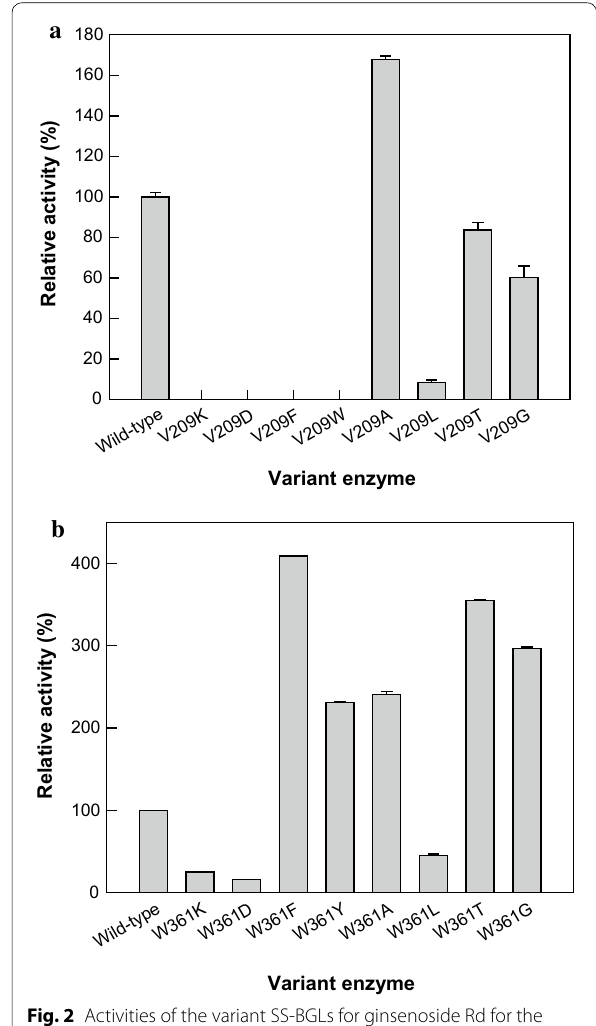
Fig. 2 Activities of the variant SS‑BGLs for ginsenoside Rd for the conversion to compound K. a Activities of the variant enzymes with mutations at position 209 of SS‑BGL. b Activities of the variant enzymes with mutations at position 361 of SS‑BGL. Data represent the means from three separate experiments, and the error bars repre‑ sent standard